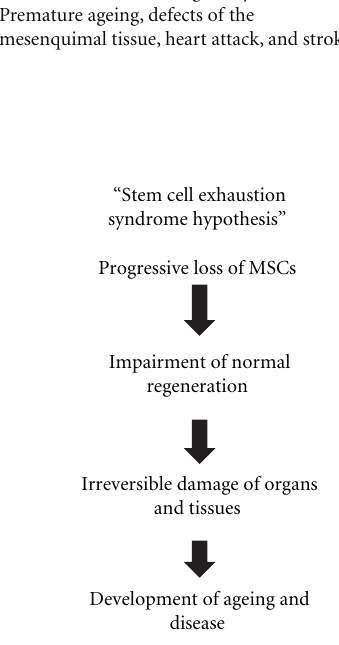
Figure 2: Stem cell exhaustion syndrome